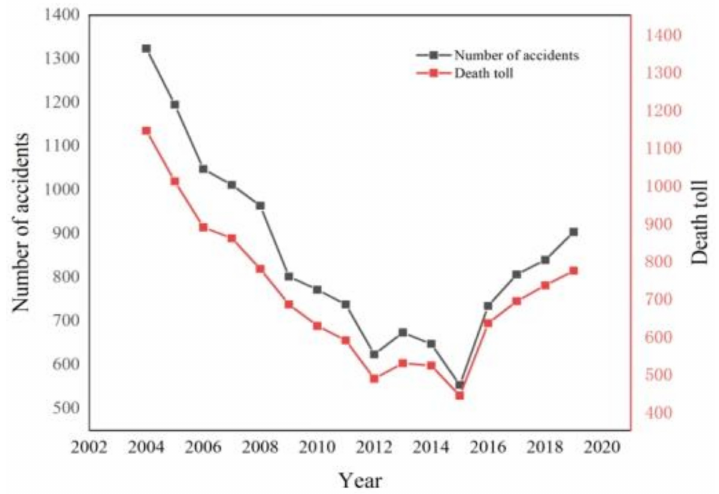
Figure 1. The number of accidents and death toll in construction in China from 2004 to 2019.